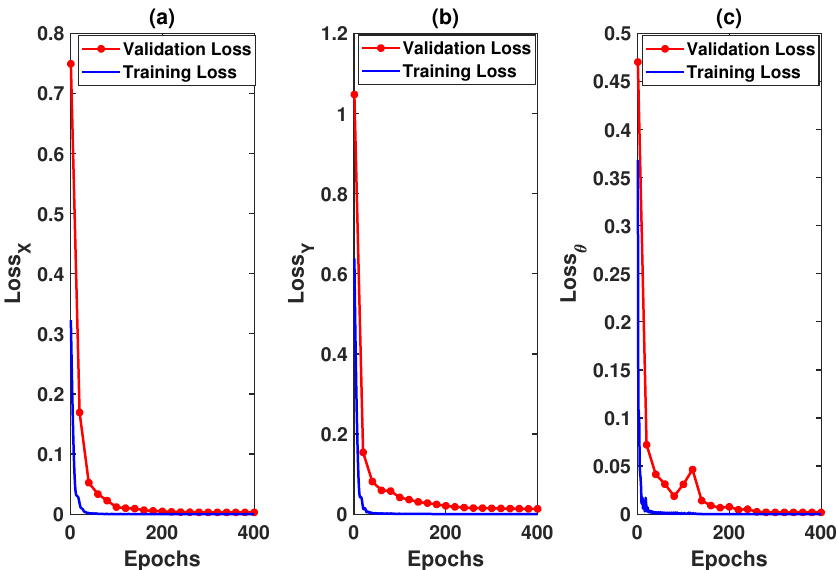
Figure 6. Training and validation loss for LSTM: ( a ) loss for X; ( b ) loss for Y; ( c ) loss for heading angle.